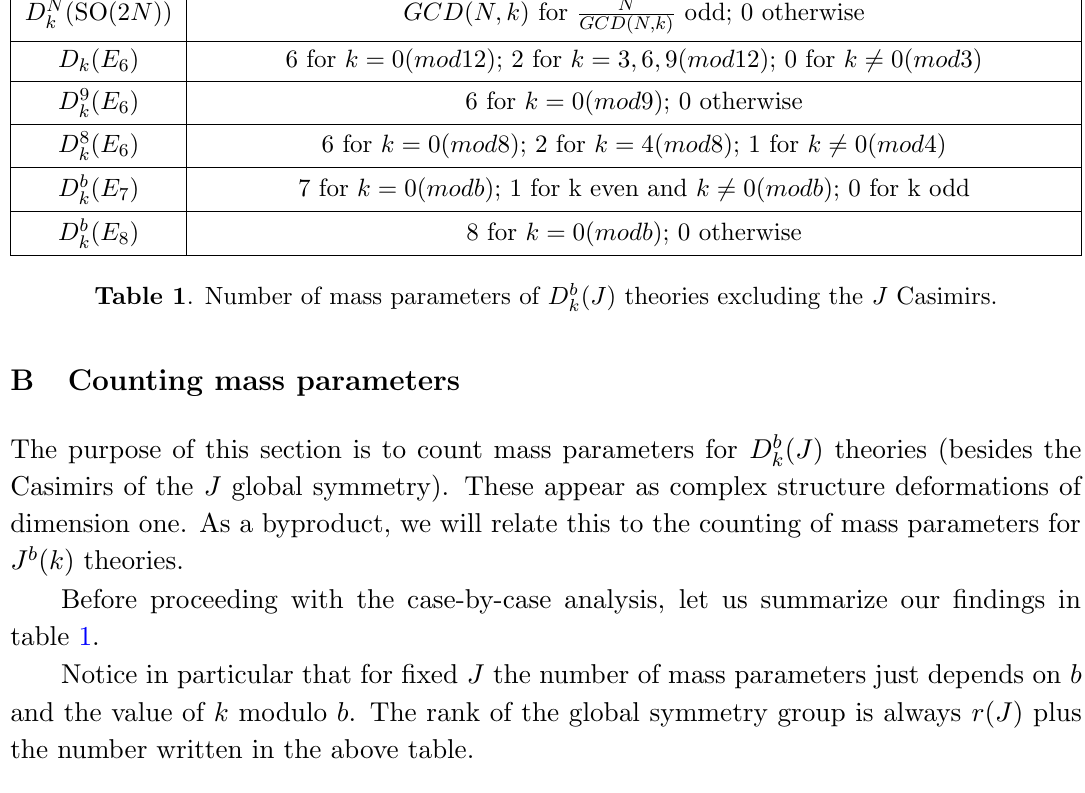
Table 1 . Number of mass parameters of D b